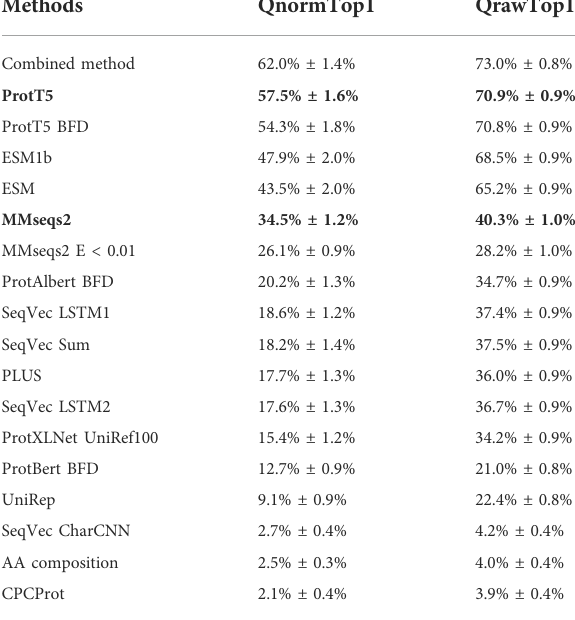
TABLE 1 Performance on CATH20 a .